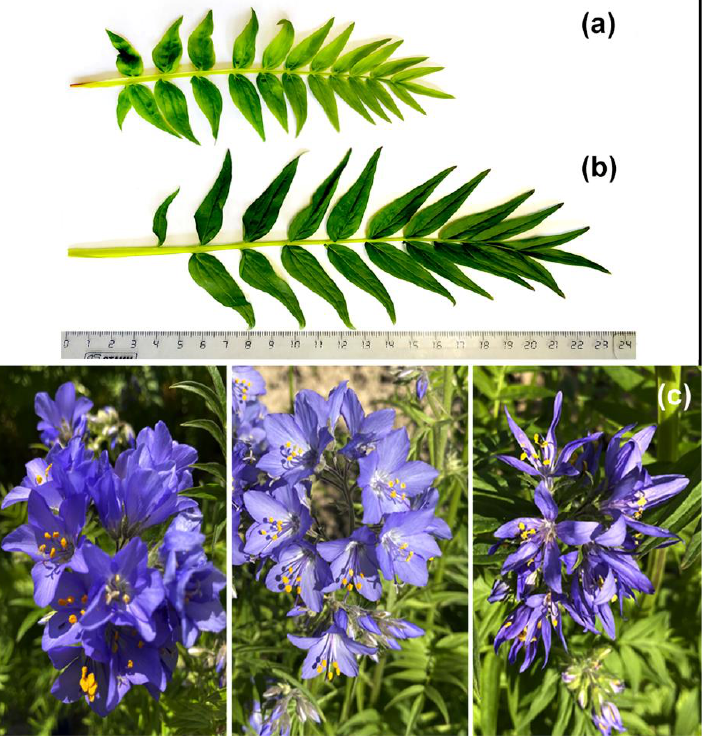
Figure 3. Leaf blades of the diploid ( a ) and tetraploid ( b ) plants of Polemonium caeruleum; the diversity in the color and shape of inflorescences observed in the tetraploids ( c ). In tetraploid plants, the raw material productivity and seed yield exceeded (by 32% and 23%, respectively) those parameters in the control plants (Figure 4, Table 1). Weight of 1000 seeds (g) was 1.31 ± 0.116 (in diploids) and 1.54 ± 0.125 (in tetraploids). At the same time, tetraploid plants were characterized by lower sowing quality of seeds (ger- mination energy and germination of seeds) compared to the control (Figure 4). Moreover, i n tetraploid plants, the content of triterpene saponins in terms of β -escin determined in the rosettes of leaves and rhizomes with adventitious roots (23.58% and 20.36%, respec- tively) significantly exceeded those characteristics observed in the control plants (18.89% and 14.92%, respectively) (Figure 4, Table 1).